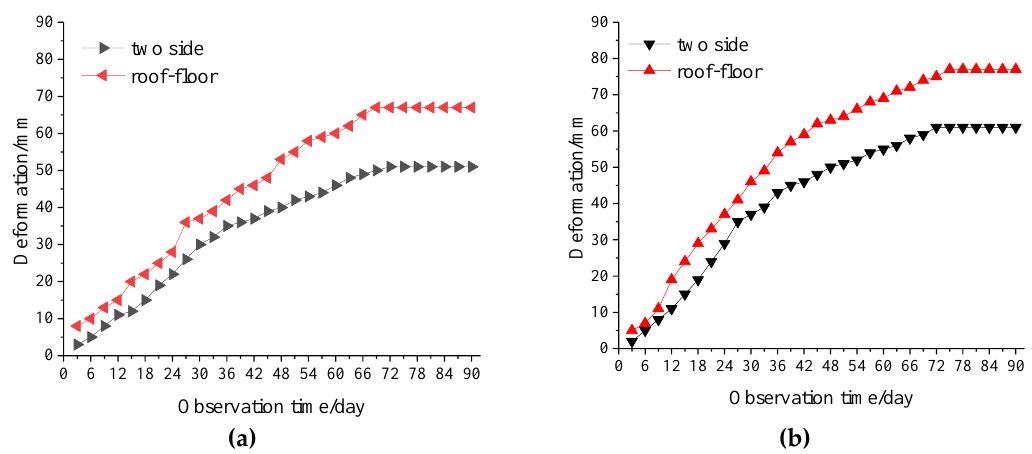
Figure 15. Roadway surrounding rock monitoring curve. Monitoring points ( a ) 1 and ( b )